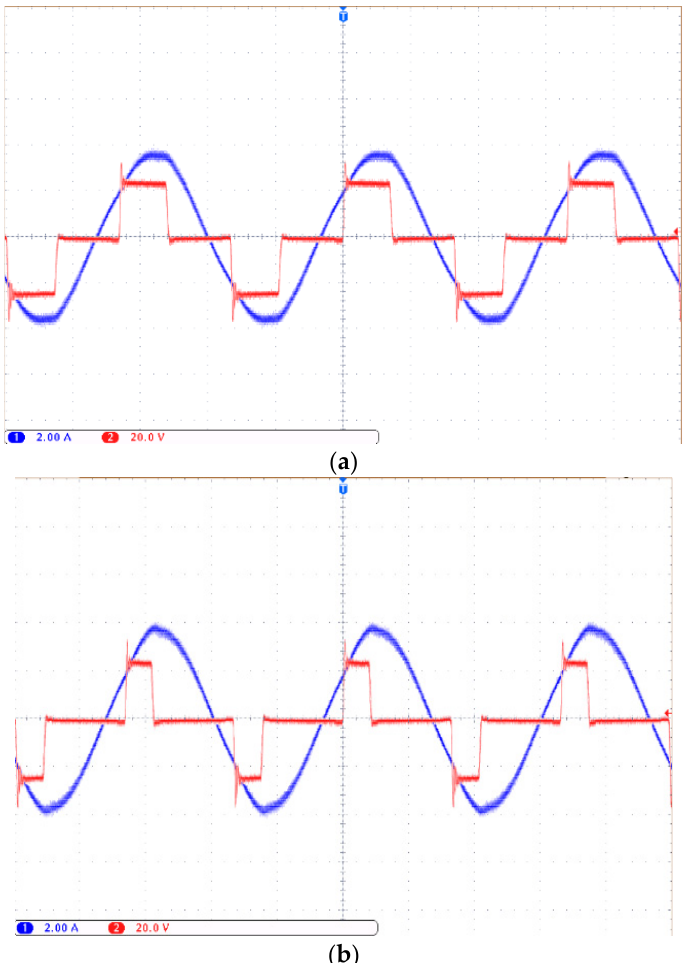
Figure 8. The output voltage (red) and current (blue) waveforms of the H-bridge inverter: ( a ) the load resistance is 20 Ω ; ( b ) the load resistance is 40 Ω . In both cases, the spread spectrum is not used. Scale: 2 A/div.; 20 V/div; 2 μ s/div.